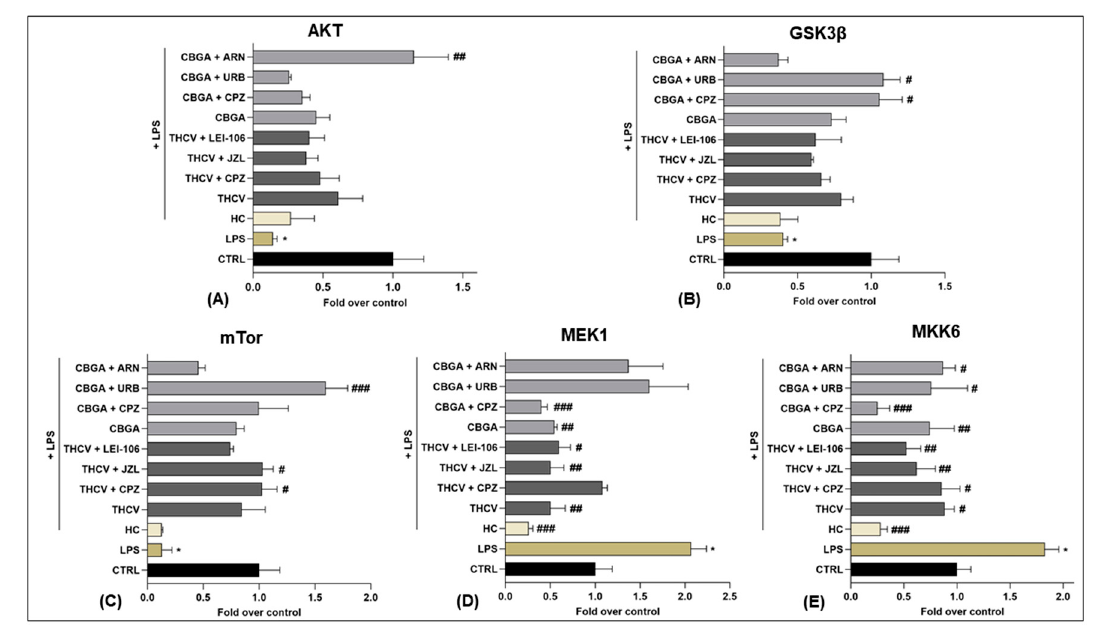
Figure 5. Expression of five of the phosphorylated proteins of the MAPK signaling pathway in HaCaT cells following 24 h treatment with LPS (5.0 μ g/mL) in the presence of pCBs (THCV (9.3 μ M) and CBGA (13.0 μ M)) and selected eCB system antagonists and inhibitors (CPZ (5.0 μ M), JZL184 (10.0 µ M), LEI-106 (10.0 μ M), URB597 (1.0 μ M) and ARN19874 (33.7 μ M)). Histograms for ( A ) AKT, ( B ) GSK3 β , ( C ) mTor, ( D ) MEK1 and ( E ) MKK6. Data are presented as means ± SEM of three inde ‐